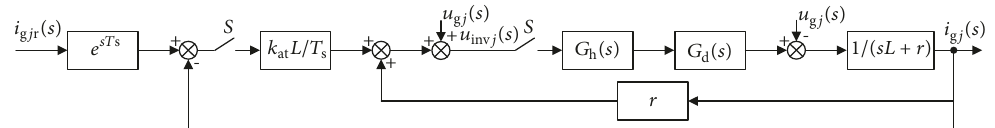
Figure 5: Diagram of the deadbeat current control for the grid-connected inverter.